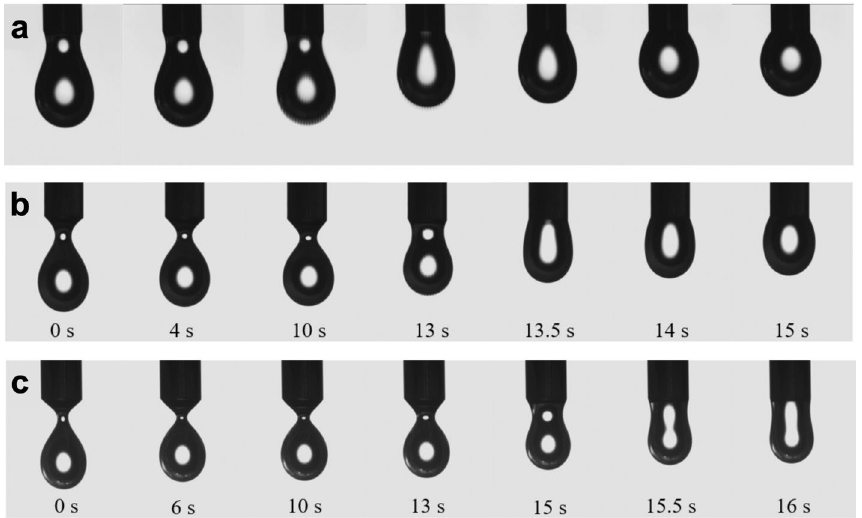
Figure 1. Snapshots of videos (see SM) from the experiments using the mixture x mM C 14 SO − 4 (S) + 10 mM α -cyclodextrin ( α -CD) + water, with R = [ S ] / [ α -CD] evolution for different ratios. ( a ) R shapes is modelled in this